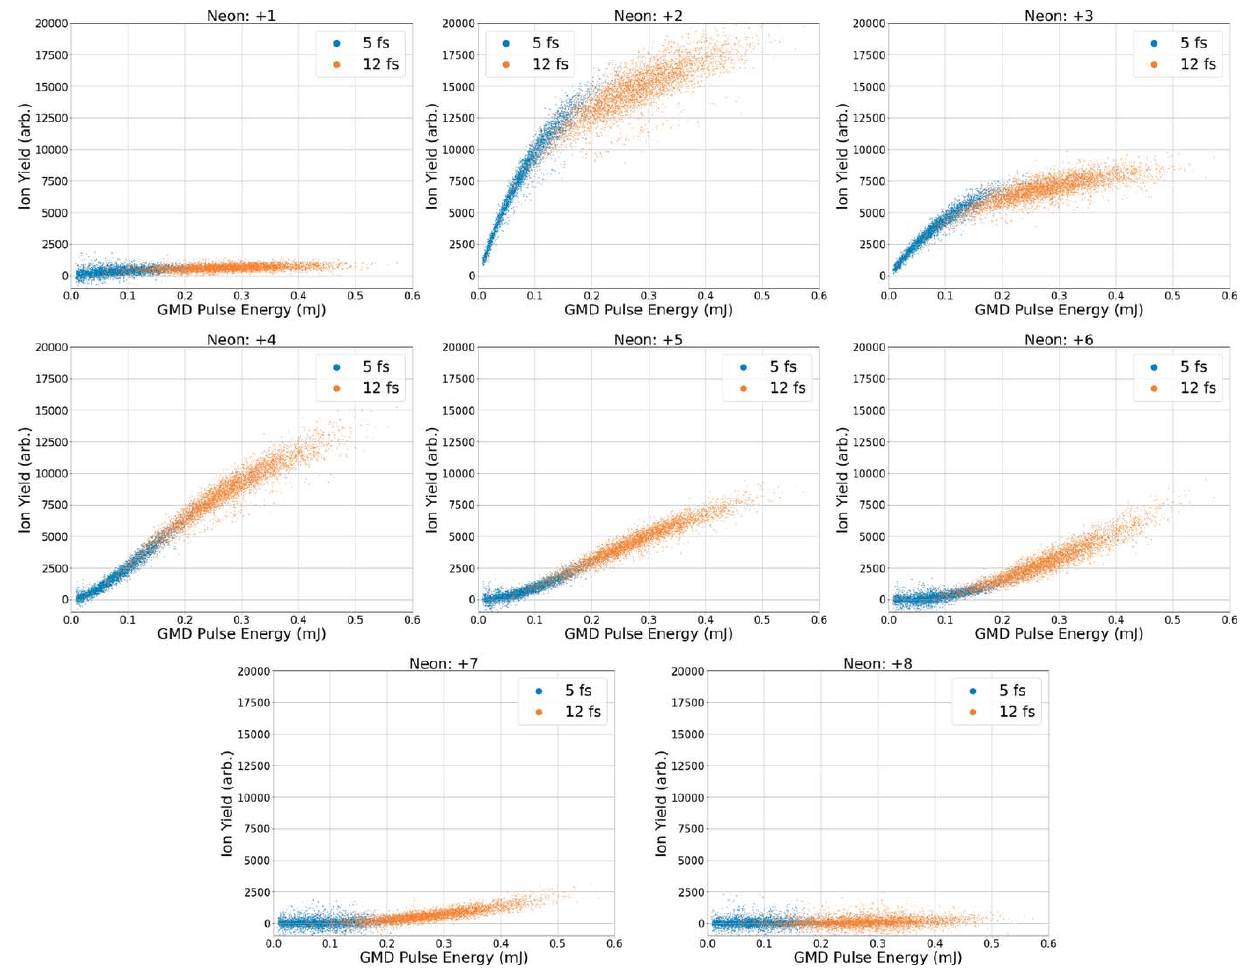
Figure 9 Ratio of charge state yield versus XGMD pulse energy for 5 fs (blue) and 12 fs (orange) electron bunch duration and at a photon energy of 1050 eV. Pulse energies are measured in the XGMD upstream of the target. The charge states 9+ and 10+ were not observed in the single-shot spectra. The shown ratios are in good agreement with the literature for this photon energy (Young et al. ,